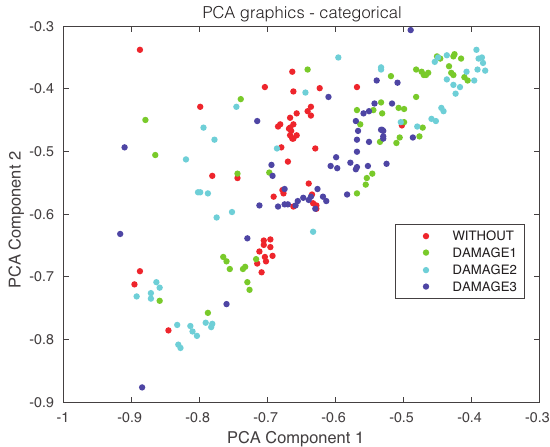
Figure 14. Cumulative contribution rate of variance for the principal components.